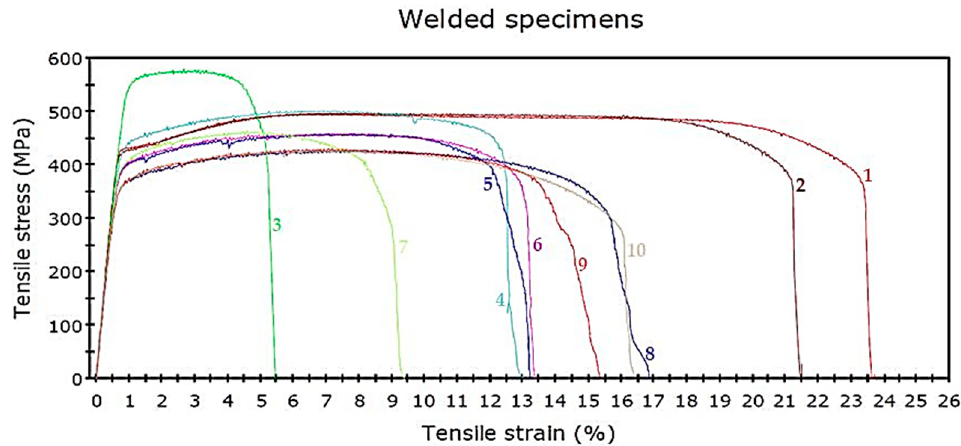
Figure 13. Engineering stress–strain curves of the specimens after hot-wire plasma